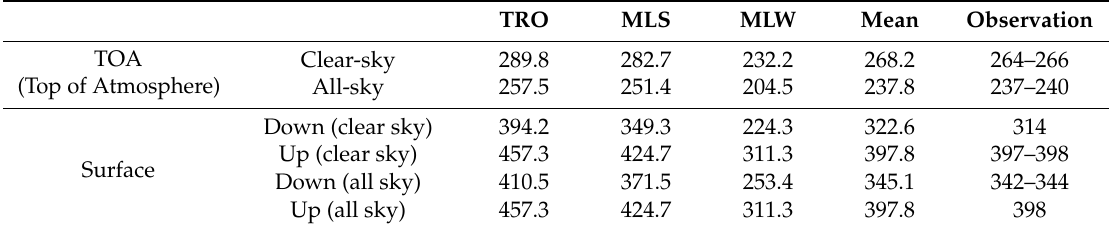
Table 2. Global mean radiative flux results from the Line-by-Line Radiative Transfer Model (LBLRTM) using the average of three atmospheric profiles and observations are compared.